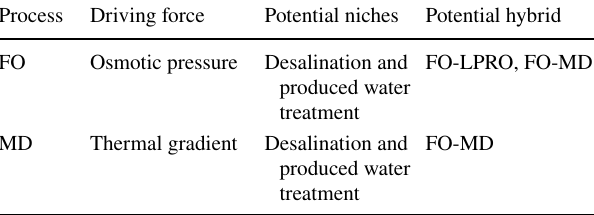
Table 2 Few examples of hybrid techniques with their corresponding driving force and potential niches Adapted from Amy et al. (2017)